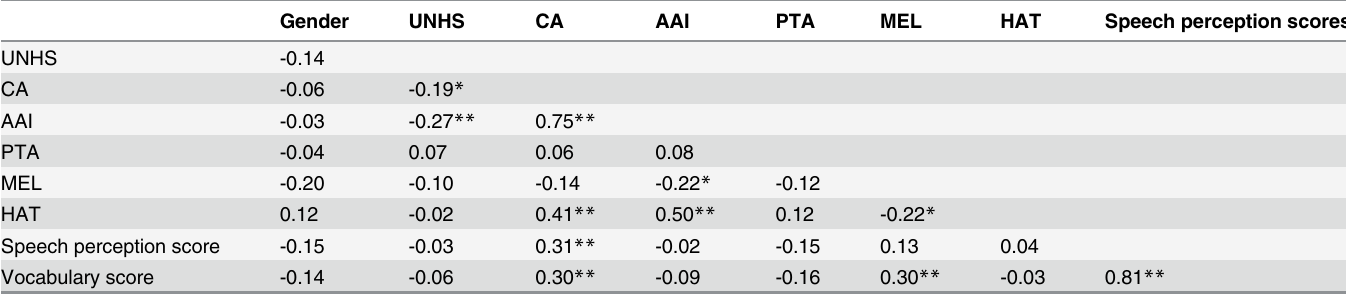
Table 3. Correlation coefficients among variables in the a priori model.